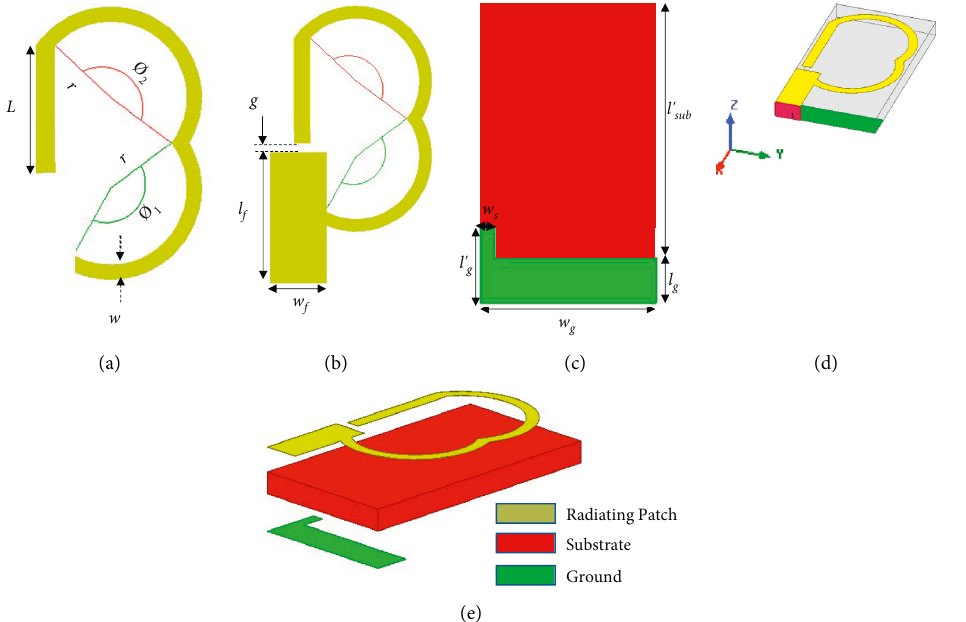
Figure 1: The proposed antenna (a) radiating patch (b) Radiating patch with the AMF-line (c) Back-view (d) feeding port (e) 3-D